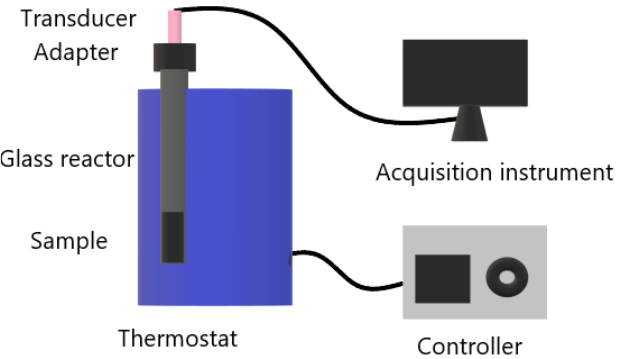
Figure 8. The diagrammatic sketch of the instrument for measuring gas